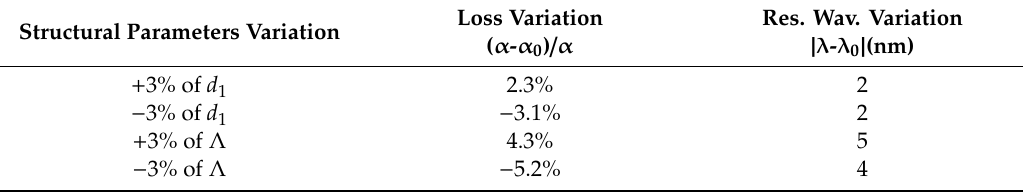
Table 3. Fabrication tolerance for the structural parameters of d 1 and 2